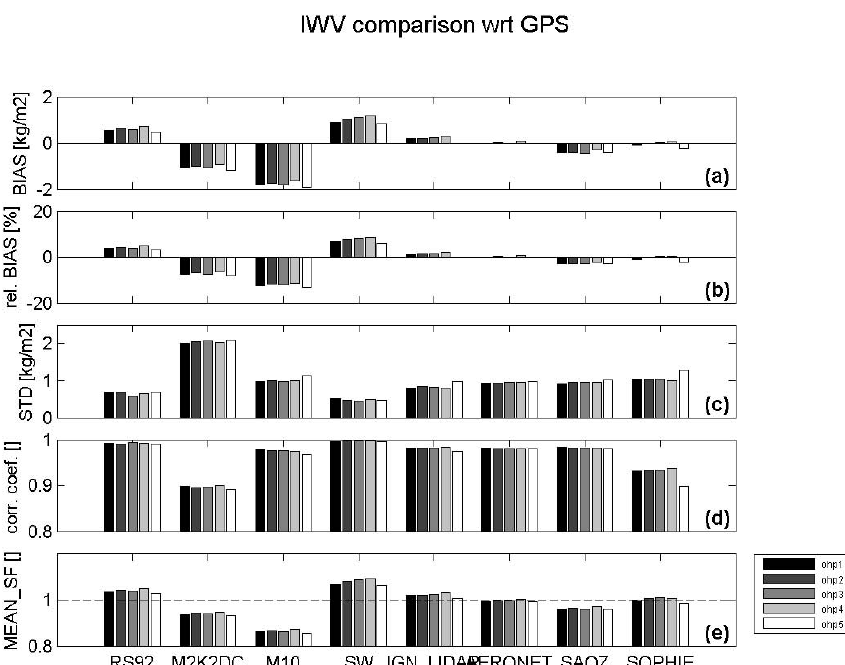
Fig. 17. Comparison of IWV from eight instruments to the IWV measured by the five GPS stations (black to white bars): (a) mean differ- ence (kgm − 2 ), (b) mean relative difference (%), (c) standard deviation of difference, (d) correlation coefficient, and (e) mean scale factor MEAN_SF =